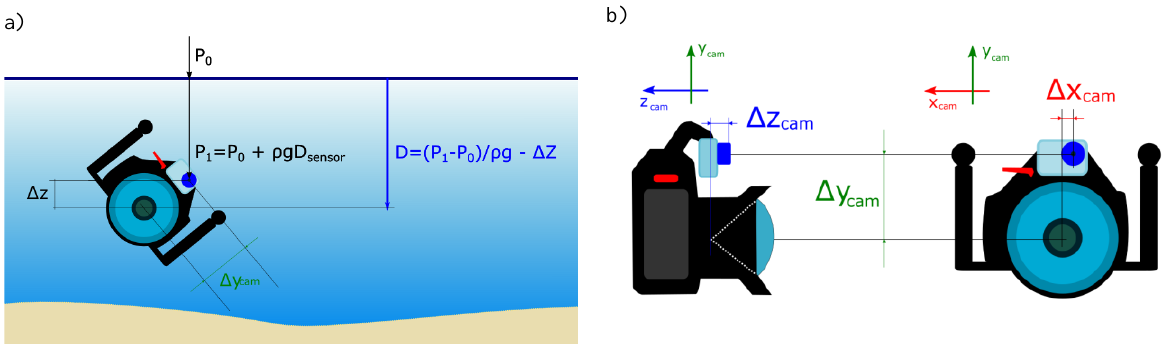
Figure 2 . Underwater depth measurement of the camera center using a pressure sensor attached to the underwater camera. The depth of the camera center (a) is a function of the measured pressure, exterior orientation parameters and (b) lever arm offsets between the pressure sensor center and the entrance pupil of the lens.